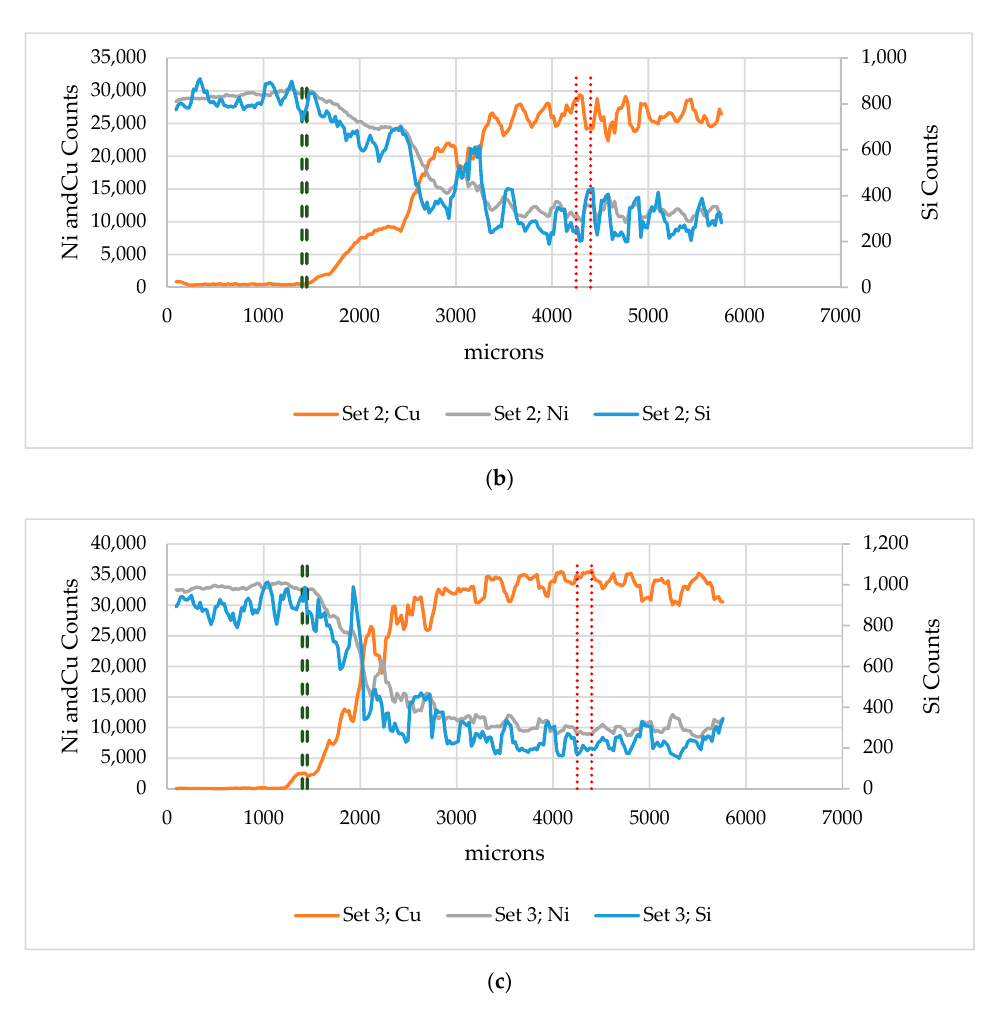
Figure 12. EDS line scan analyses across dissimilar graded material interfaces for the three sets, ( a ) set 1, ( b ) set 2, and ( c ) set 3, of the duty cycle ramp downs (see Figure 2) when 30/70 copper-rich deposits were fabricated onto the 100/0 nickel-rich pre-deposit.